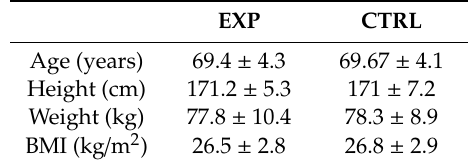
Table 1. Participant characteristics (mean ±